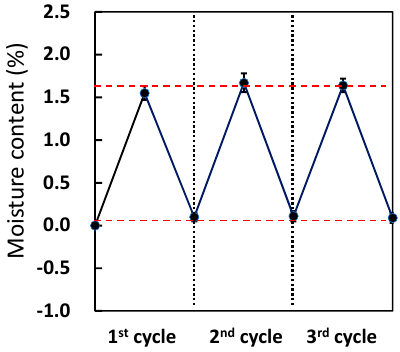
Figure 7. Moisture content of dry CFRP samples during repetitive moisture absorption at 120 °C for 72 h and drying at 100 °C for 72 h under a reduced pressure.